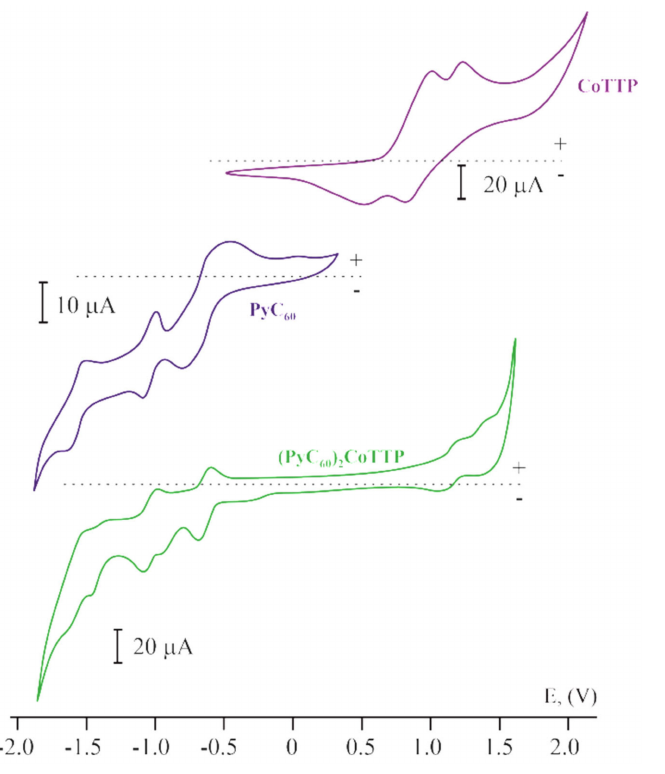
Figure 9. The cyclic voltammograms for CoTTP, PyC 60 and (PyC 60 ) 2 CoTTP in CH 2 Cl 2 containing the